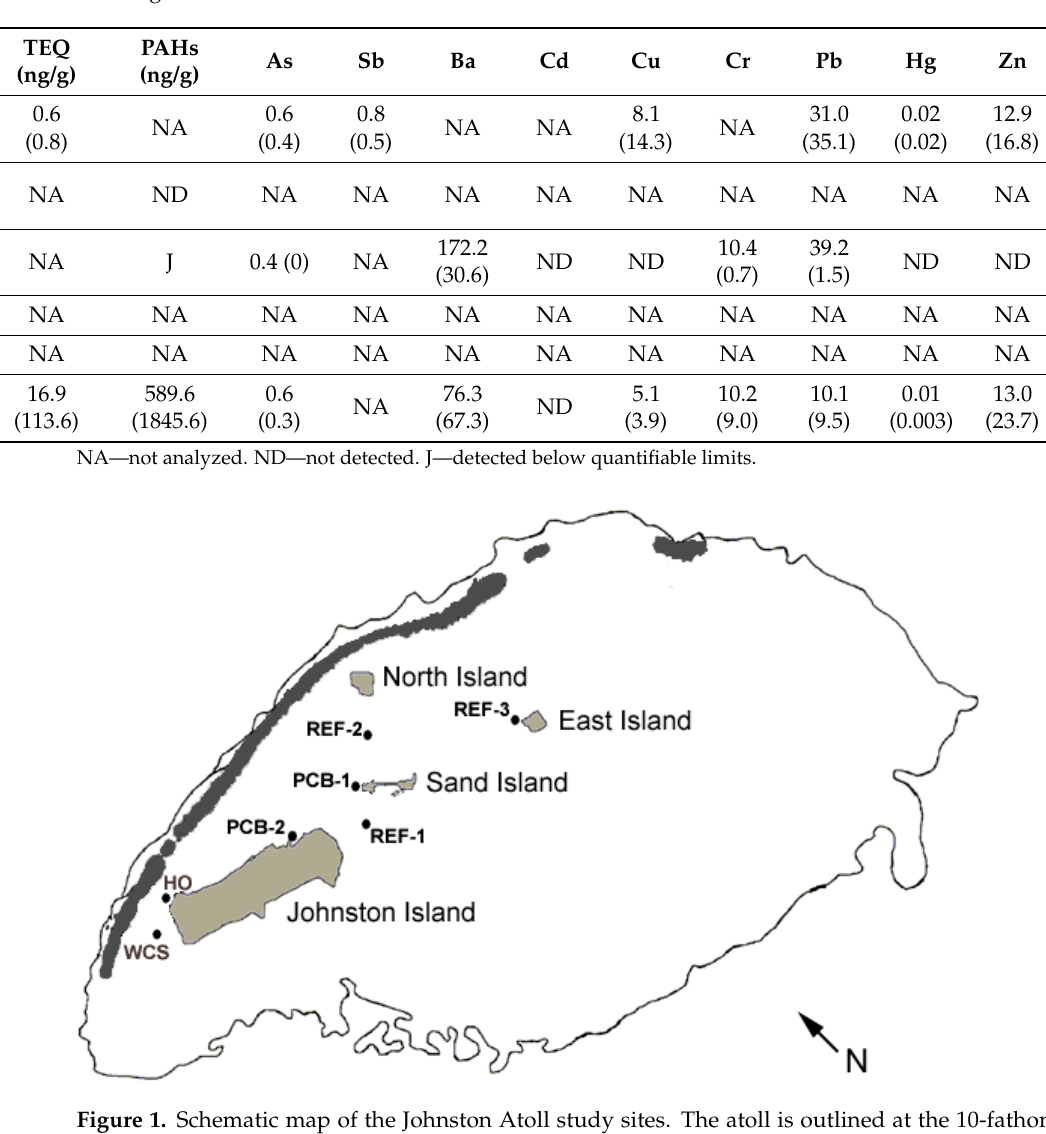
Table 1. Mean (SD) concentration of sediment contaminants found in selected regions of the Johnston Atoll lagoon.